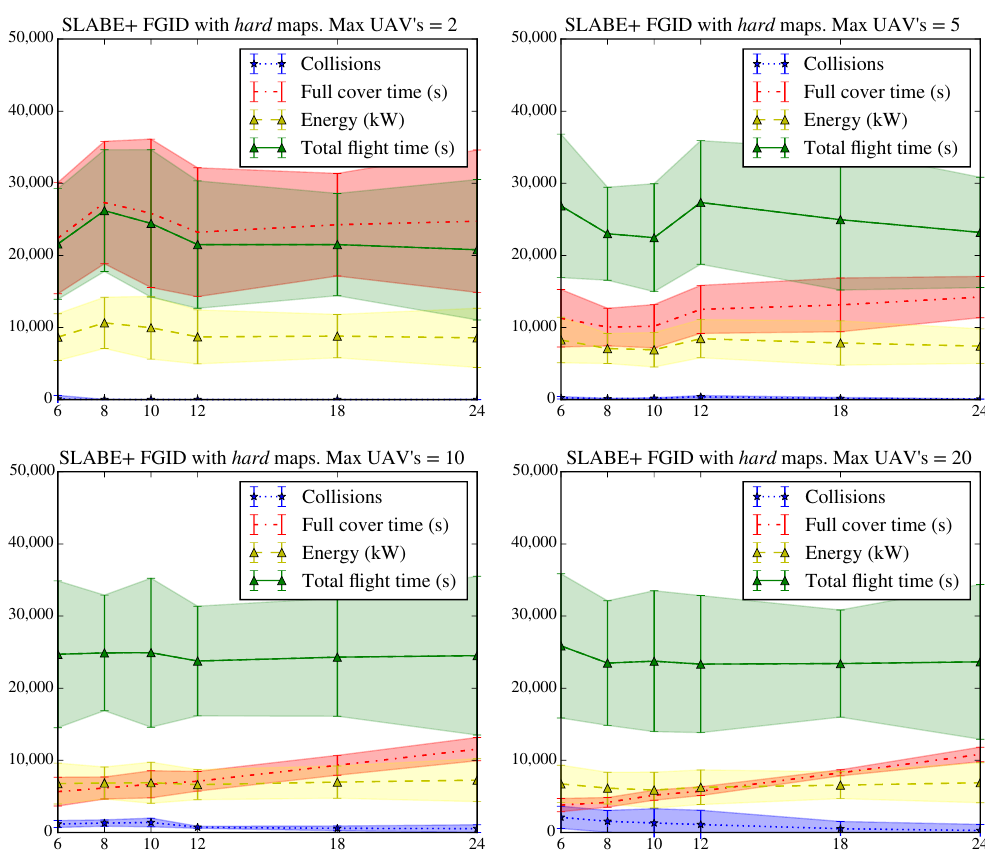
Figure 18. Results of the SLABE behavior simulations for the FGID take-off strategy in a hard environment. The graph shows the average evolution and variation of the number of collisions, the time required to achieve 95% coverage of the environment, the energy consumed by the swarm, and the total flight time for 600 simulations (50 simulations on the same map for each combination of take-off time interval and maximum number of vehicles in